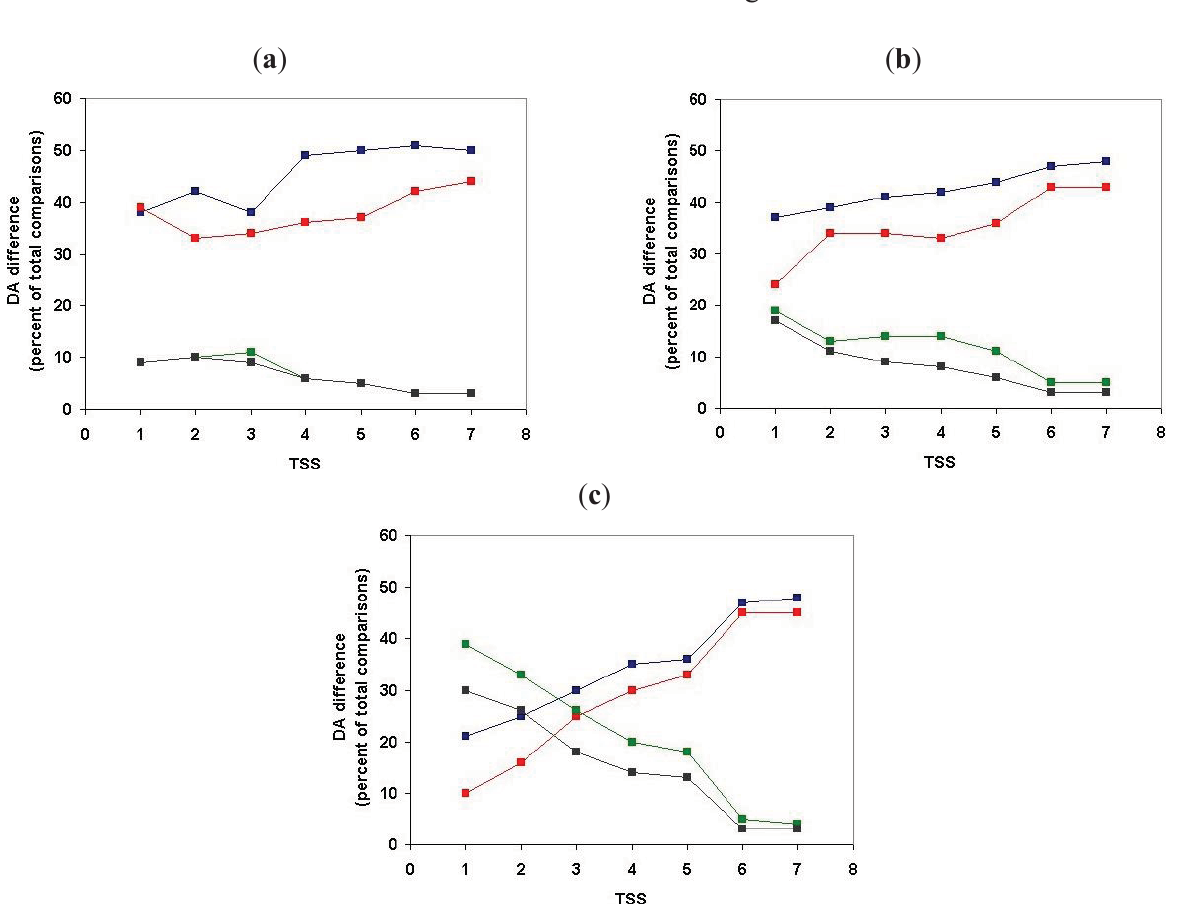
Figure 10. Analysis of the positional distribution of DA differences of paralogous human Swiss-Prot sequences differing in single domains. The numbers on the abscissa indicate the number of top-scoring matches included in the analyses (TSS = 1, .... TSS = 7) used to define paralogous clusters. N-terminal differences (blue recrangles), C-terminal differences (red rectangles), internal differences (green rectangles), tandem duplications (black rectangles). (a) Positional distribution of DA differences for type 1 transitions; (b) Positional distribution of DA differences for type 2 transitions (note that, in the case of the closest paralogs (TSS = 1), the proportion of terminal and internal DA differences are comparable); and (c) Positional distribution of DA differences for type 3 transitions. Note that in the case of closest paralogs (TSS = 1 and TSS = 2) the proportion of internal DA difference exceeds those of N-terminal or C-terminal